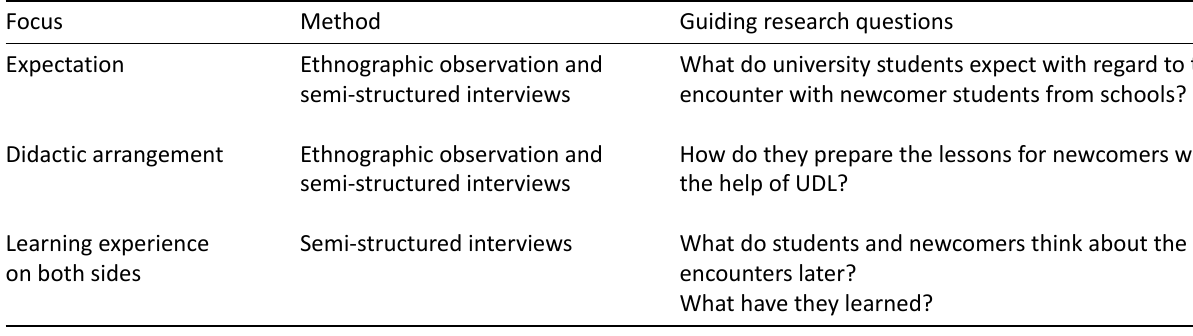
Table 1. Research